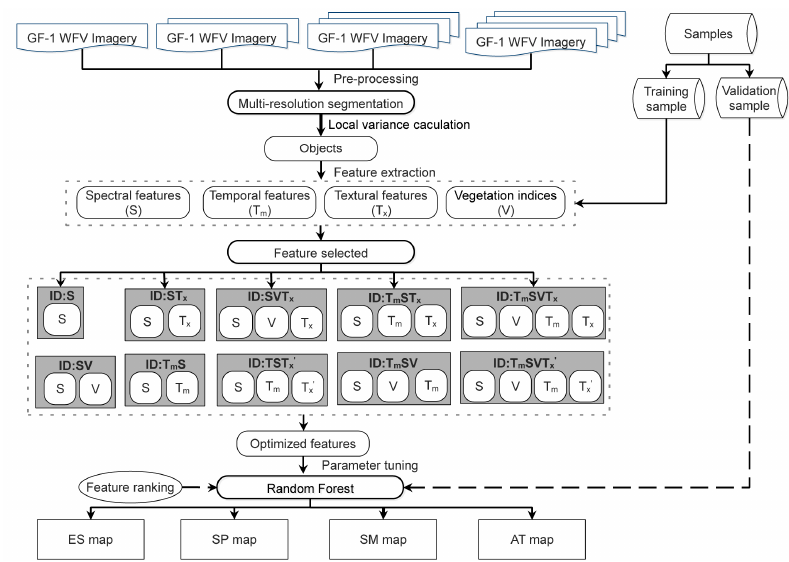
Figure 3. Flow diagram of the processing and analysis steps. ID group of feature scenario; S spectral feature; T x texture feature; T m temporal feature; T x ’ in-season texture feature; ES in the early spring season; SP in the spring season; SM in the summer season; AT in the autumn season.